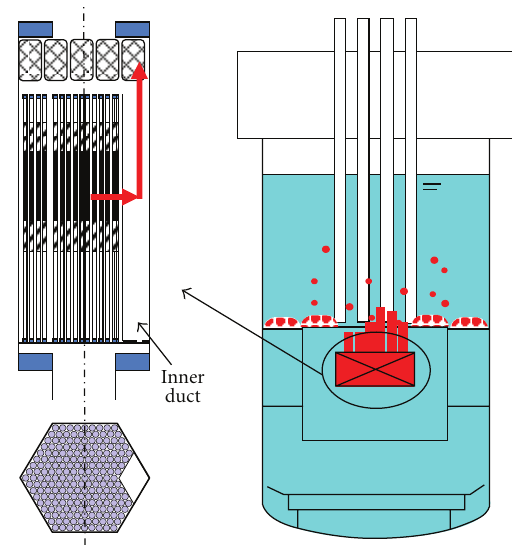
Figure 10: Fuel assembly with inner duct for enhancing molten fuel